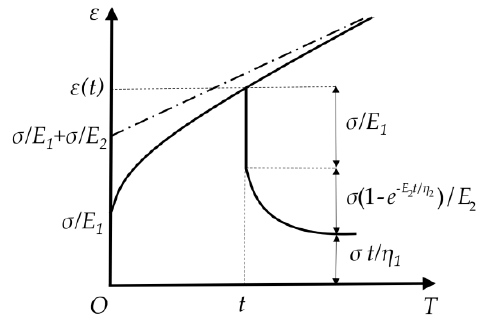
Figure 7. The Burgers creep curve.